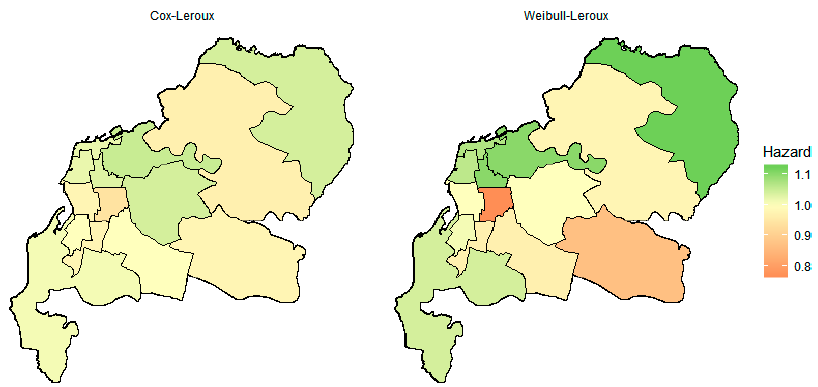
Figure 2. Spatial hazard ratios in each district for Cox and Weibull Bayesian models with the Leroux